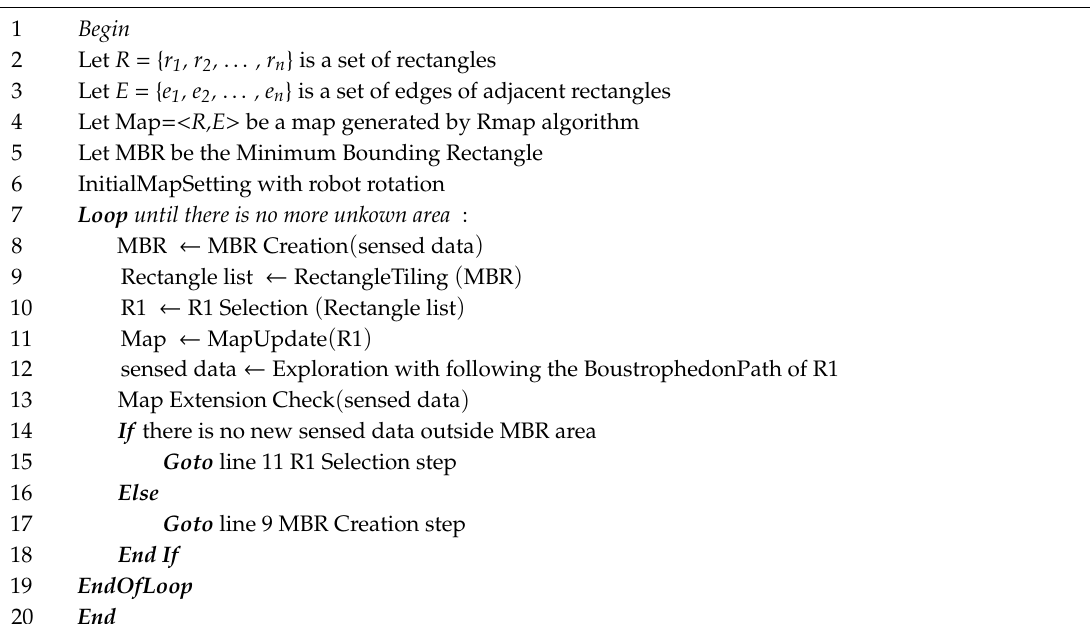
Algorithm 2. Modified Rmap Algorithm for Coverage